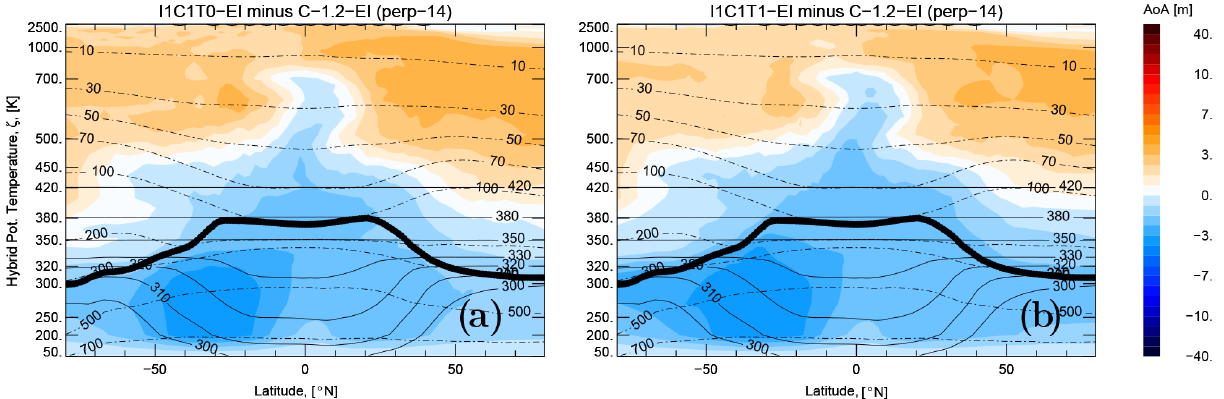
Figure 8. Impact of tropospheric transport modes on the distribution of the age of air (AoA) (in months) shown as a difference to the CLaMS 1.2 AoA distribution (December 2017, perpetuum 14yr): with unresolved convection (a) , and with unresolved convection and tropospheric mixing (b) . The results for the respective E5-driven simulations are very similar in the troposphere; the stratospheric effect of aging by mixing is even weaker (not